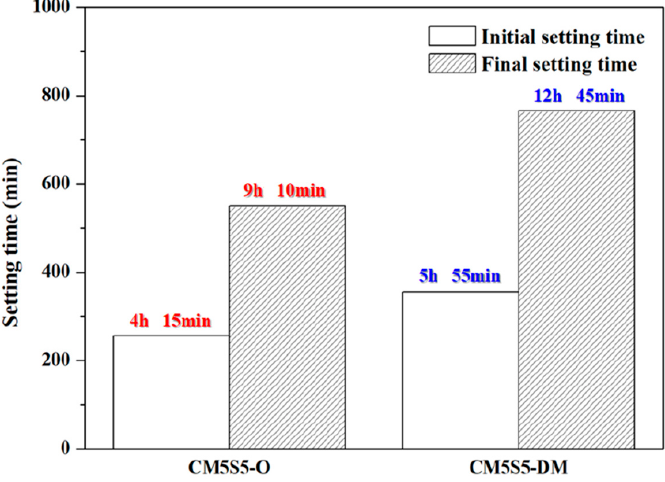
Figure 2. Setting time of marble-based geopolymer.